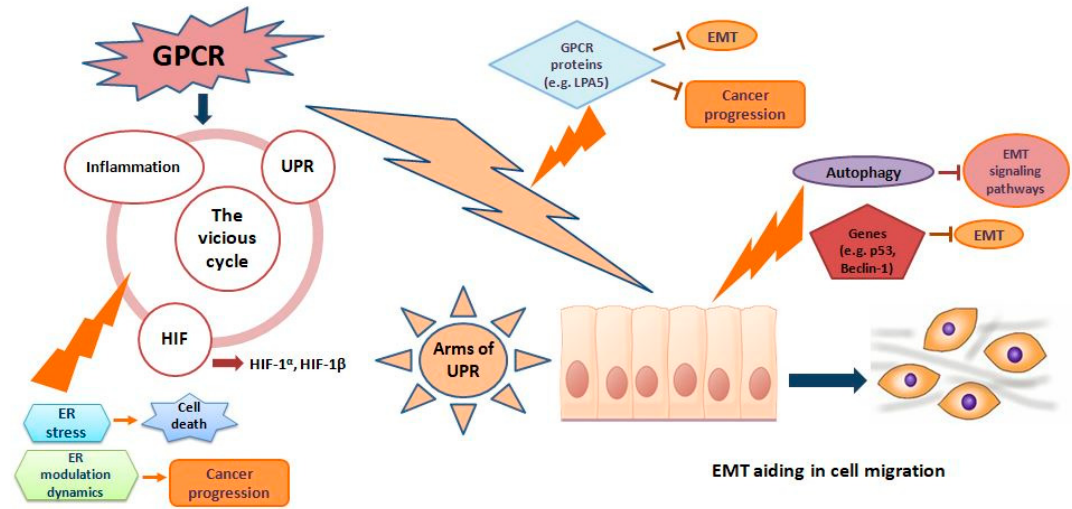
Figure1. TargetsitesoftheendogenouscandidatesofG-proteincoupledreceptors(GPCR),Endoplasmic reticular stress (ER) stress and epithelial mesenchymal transition (EMT). Mounting evidence suggests that GPCR activates unfolded protein response (UPR) in various cancers via mediators like inflammation. Sublethal UPR activation and signalling via IRE1a, PERK, and ATF6a sustain multiple cell-intrinsic and cell-extrinsic mechanisms of tumour progression. ER-stress-mediated activation of central signalling hubs, such as HIF1a, STAT3, NRF2, and NFkB, aides cell survival under harsh microenvironmental conditions and preserves tumour-initiating cell function. Intrinsic cancer cell apoptotic resistance is likely crucial for harnessing ER stress to enhance tumour growth. GPCR protein LPA5 is to exhibit anti-cancer potential by inhibiting mechanisms like EMT. EMT pathways and genes like p53 and Beclin-1 play a positive role in cancer therapeutics. Likewise, certain modulations of ER dynamics and proteins aids in protecting cells from gaining pro survival capability and impeding mechanisms like